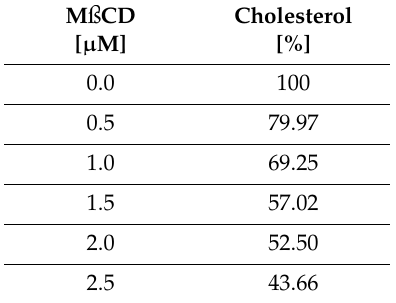
Figure 8. (Left) Diagrams of the modified p -value and reduced chi-square characterizing the linear fitting of the parameters α (a) , β (b) , γ (c) , and δ (d) , with MßCD plotted, as a function of the multiplication factor (M.F.). We identify the M.F. value, for which the corresponding p -value and reduced chi-square are optimized. The goodness of fit is shown using both the modified p -value and reduced chi-square. (Right) Here, the goodness of fit is shown using the unified measure as given by Equation (9) while it is depicted as a function of the signal-to-noise ratio of the slope b/ δ b , characterizing the linear fitting of the parameters with MßCD; (note: Both the ratio b/ δ b and the goodness of fitting are plotted as functions of the multiplication factor (M.F.)). The cases of the parameter α and γ have the optimal values of the p -value and reduced chi-square for │ b/ δ b │ < 1, so that the hypothesis of being dependent on MßCD is rejected. On the other hand, the cases of the parameter β and δ have the optimal values of the p -value and reduced chi-square for │ b/ δ b │ >> 1, thus, the hypothesis of MßCD dependence is accepted.